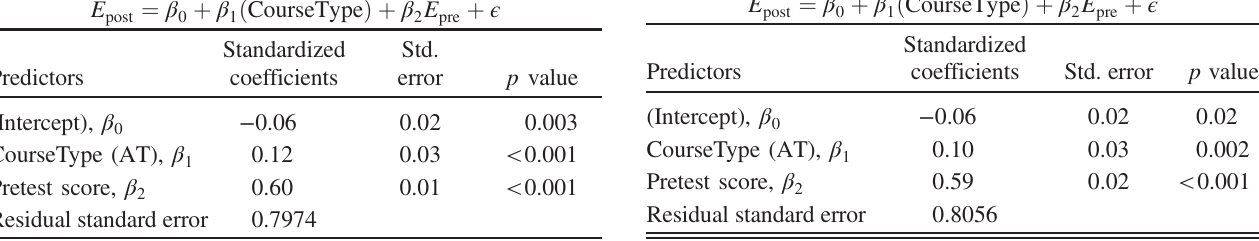
TABLE IX. Coefficients for ANCOVA for post-test scores while controlling for pretest scores for men. The table lists the standardized coefficients and the p values of the ANCOVA results for the CourseType